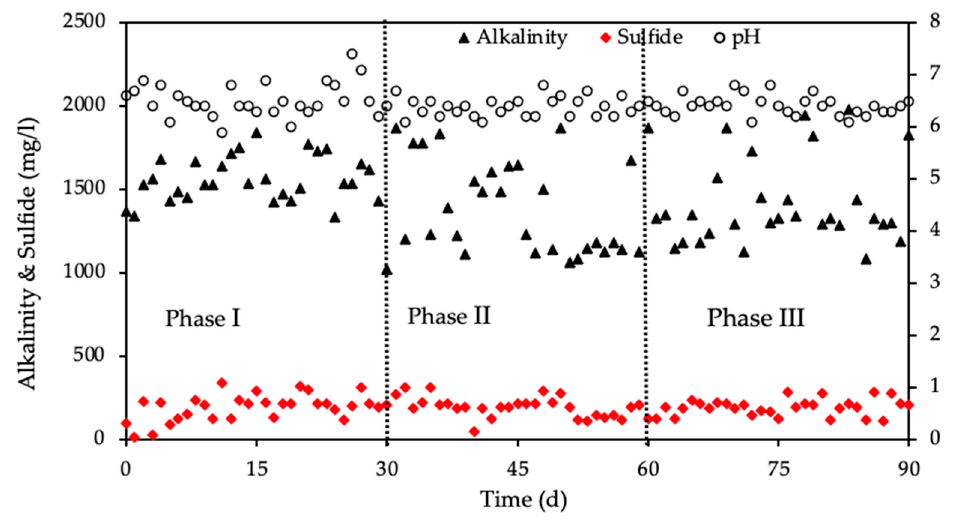
Figure 5. Alkalinity, pH, and sulfide response with time in the fluidized bed